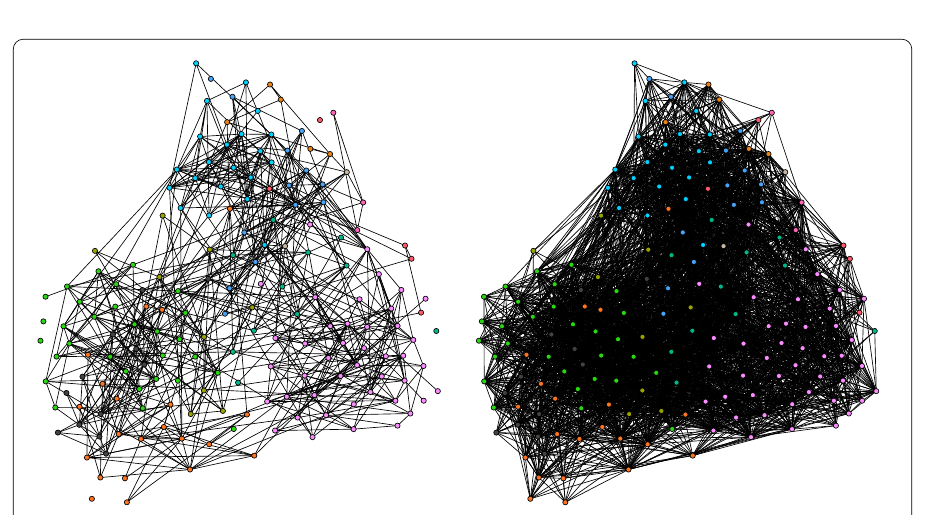
Figure 2 Contact and co-presence matrices—InVS15. Comparison between the average matrices of link density for the contacts and the co-presence daily aggregated networks. Values are averaged over all days of the data collection. Both plots have the same colour scale.